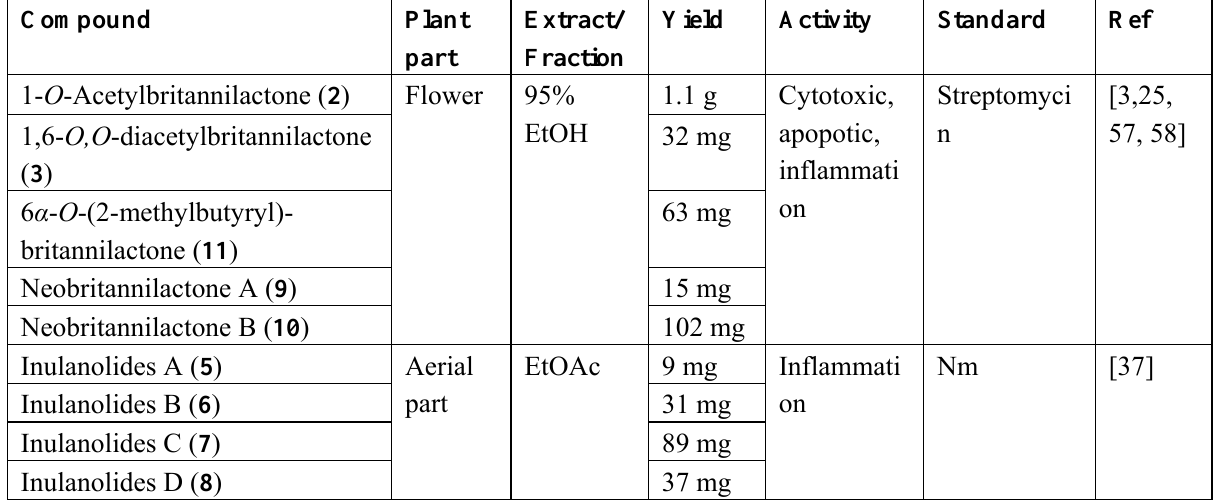
Table 2. Summary of biologically active compounds from I.